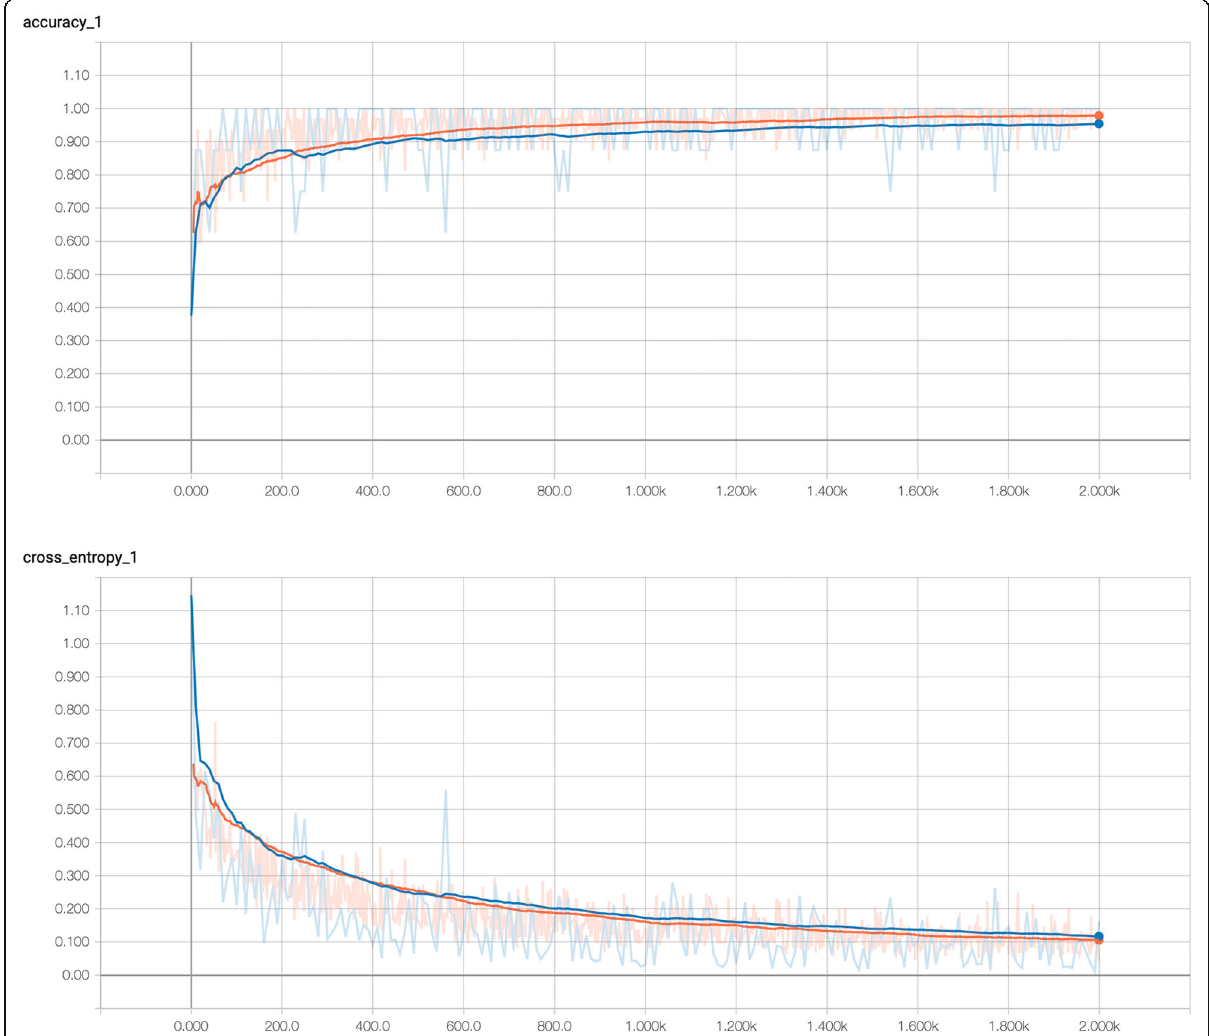
Fig. 4 Visualization of the training process (above: accuracy, below: cross entropy, orange: training set, blue: testing set). After 2000 training steps, a final accuracy of 0.969 was achieved